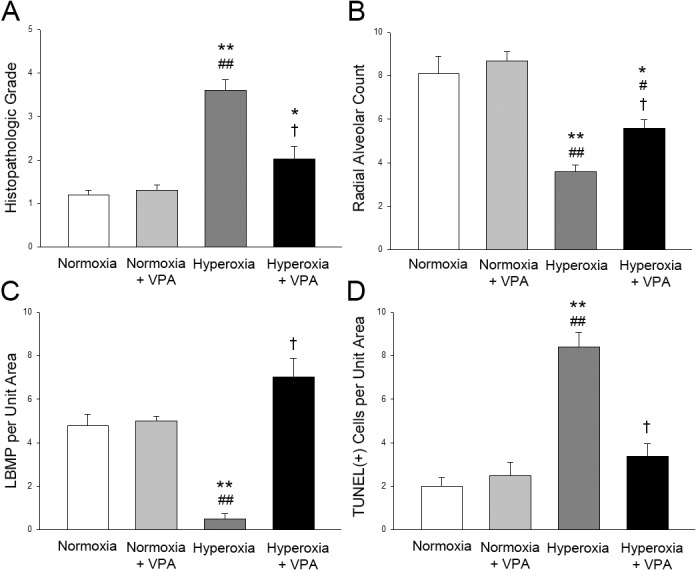
Bar graphs depicting Histopathologic Grade (A), Radial Alveolar Count (B), LBMP per Unit Area (C) and TUNEL(+) Cells per Unit Area (D) in lung tissues of rat pups.*p<0.05 and **p<0.001 compared to Normoxia group; #p<0.05 and ##p<0.001 compared to Normoxia+VPA group; and †p<0.05 and ††p<0.001 compared to Hyperoxia group using One-Way ANOVA followed by post-hoc Tukey test.